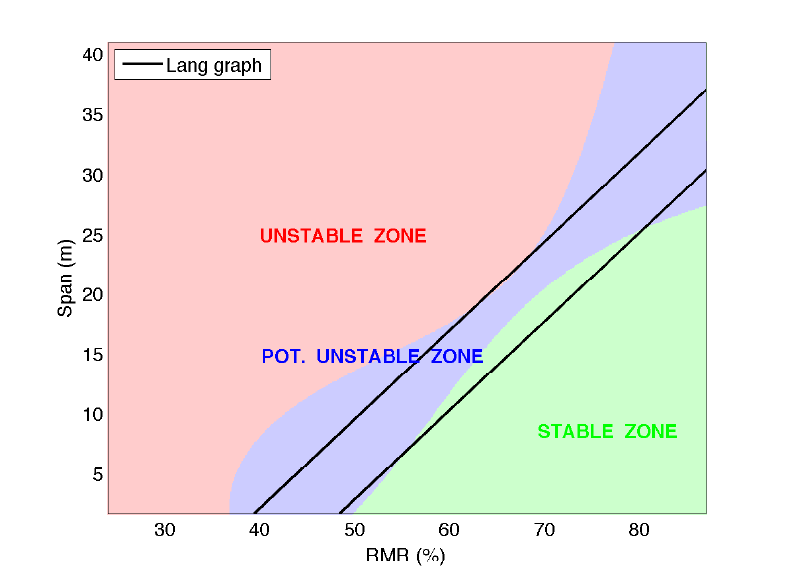
Figure 8. Critical span graph: comparison: SVM (3 groups) vs.